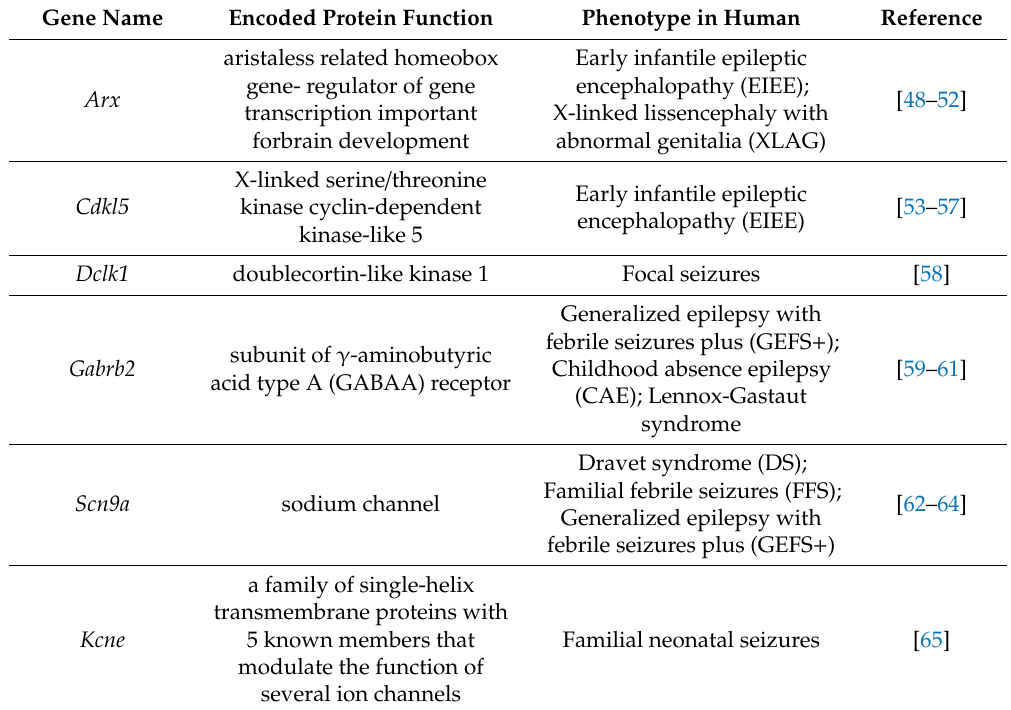
Table 3. Phenotypes of human mutations of genes which are associated with